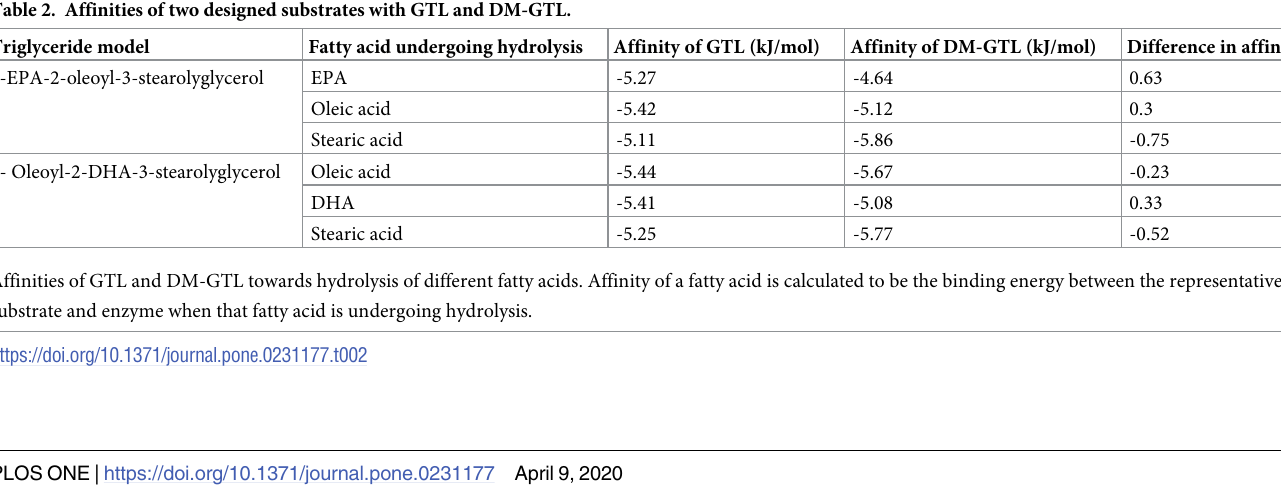
Table 2. Affinities of two designed substrates with GTL and DM-GTL. Triglyceride model